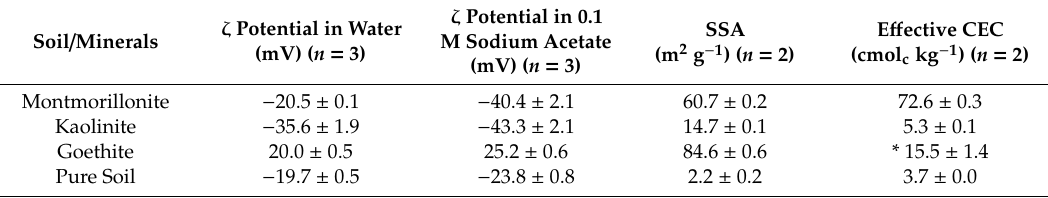
Table 1. Basic characteristics of pure minerals and the soil used for the experiments. Abbreviations: SSA, specific surface area; CEC, cation exchange capacity. Values are shown as means ± standard error ( n =